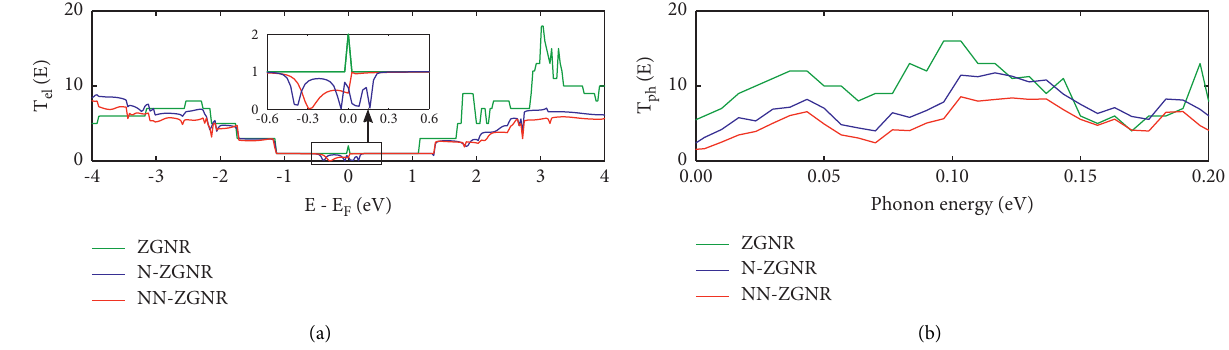
Figure 2: Electronic transmission spectrum (a) and phononic transmission spectrum (b) shown for the unperturbed ZGNR (green), N- ZGNR (blue), and NN-ZGNR (red) systems as a function of energy evaluated at T � 300K.